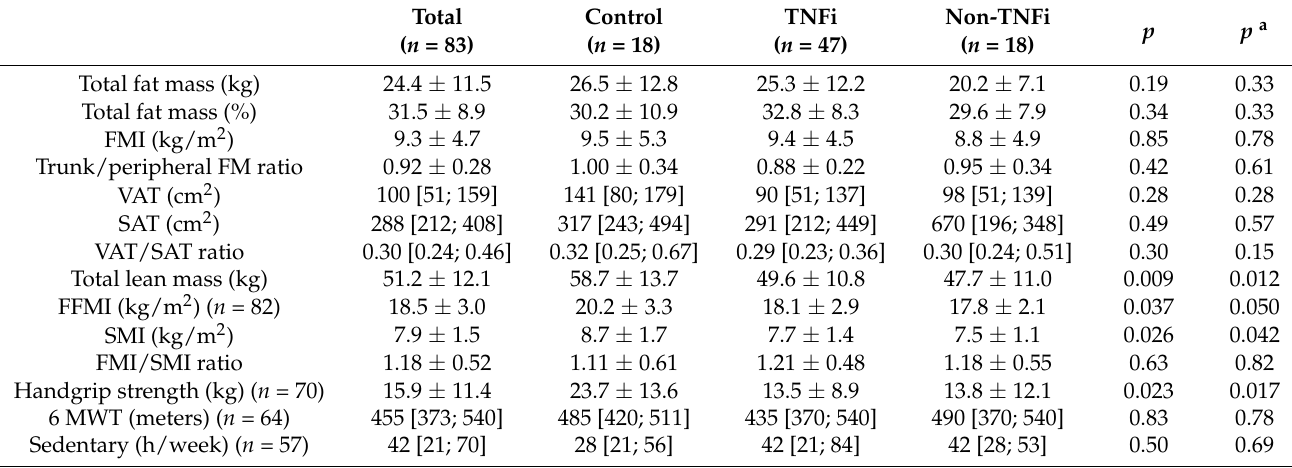
Table 2. Baseline body composition, muscle strength, and physical performance of rheumatoid arthritis